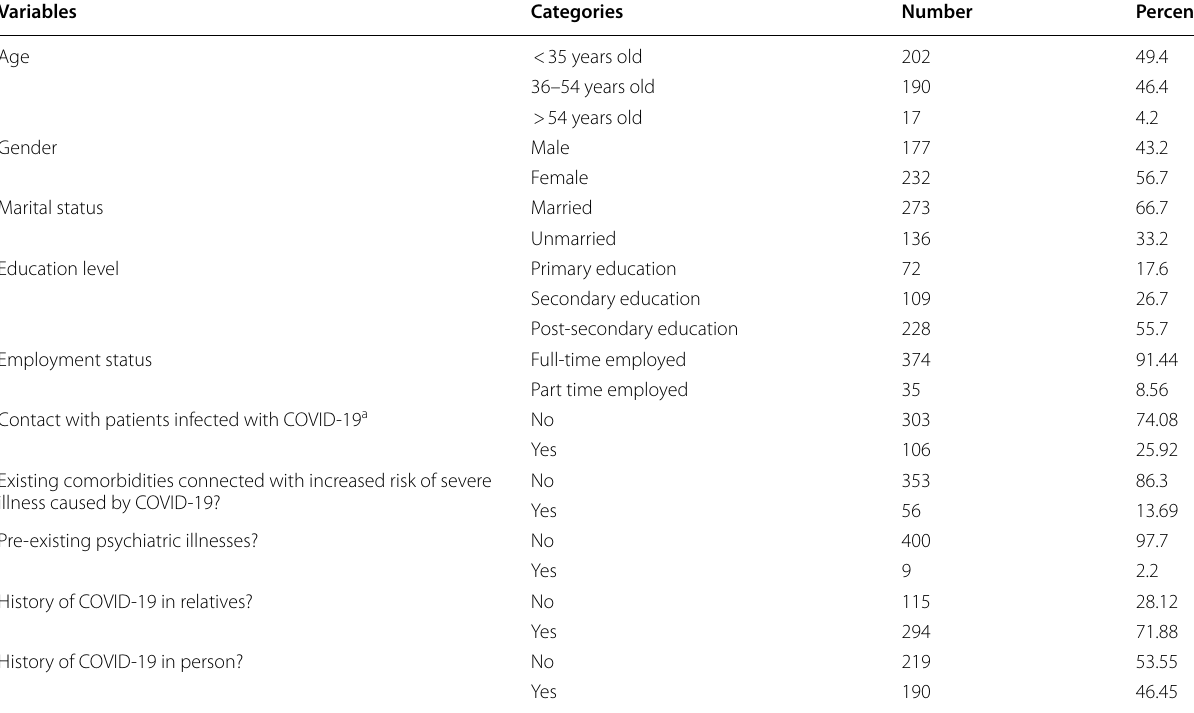
Table 1 Demographic and personal characteristics, clinical factors, and COVID-19-related stressors among the